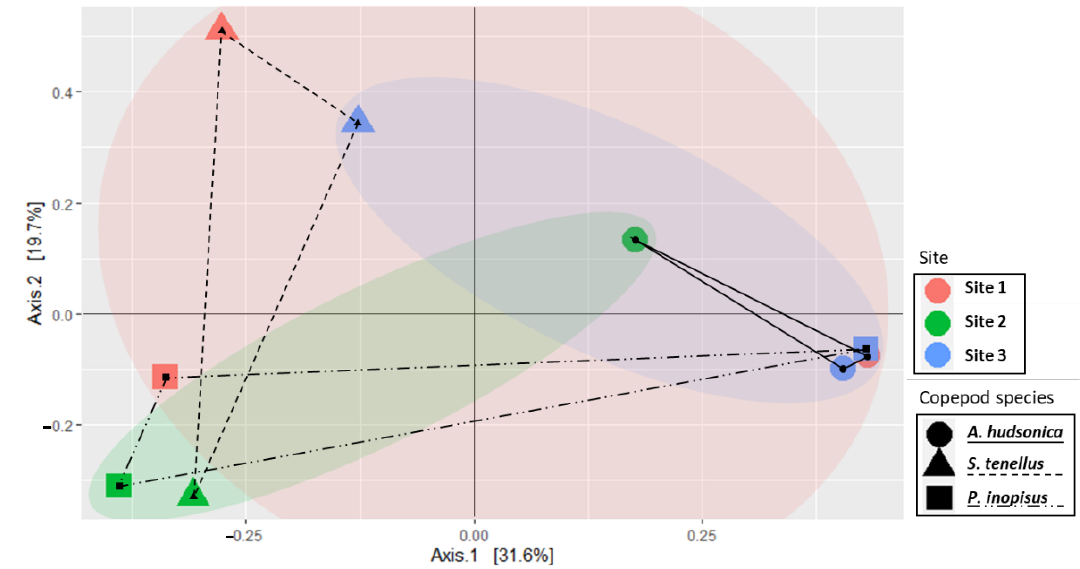
Figure 5. Biplot for a principal coordinate analysis (PCoA) of gut bacterial communities of Acartia hudsonica (circle, solid line), Sinocalanus tenellus (triangle, dotted line), and Pseudodiaptomus inopinus (rectangle, mixed line) at each site.